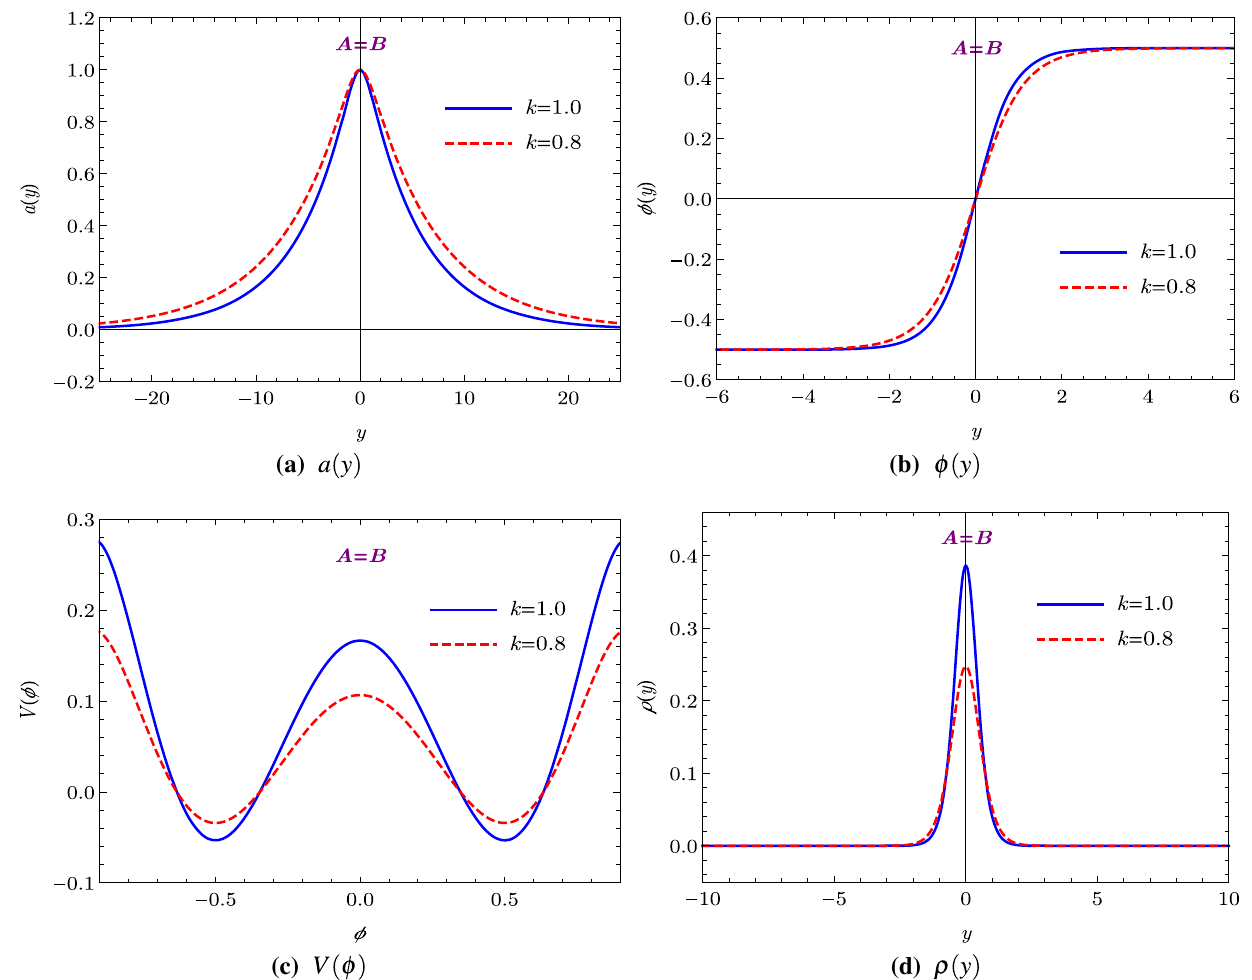
Fig. 1 The profiles of the warp factor a ( y ) , scalar field φ( y ) , scalar potential V (φ) , and energy density ρ( y ) for the case of A = B